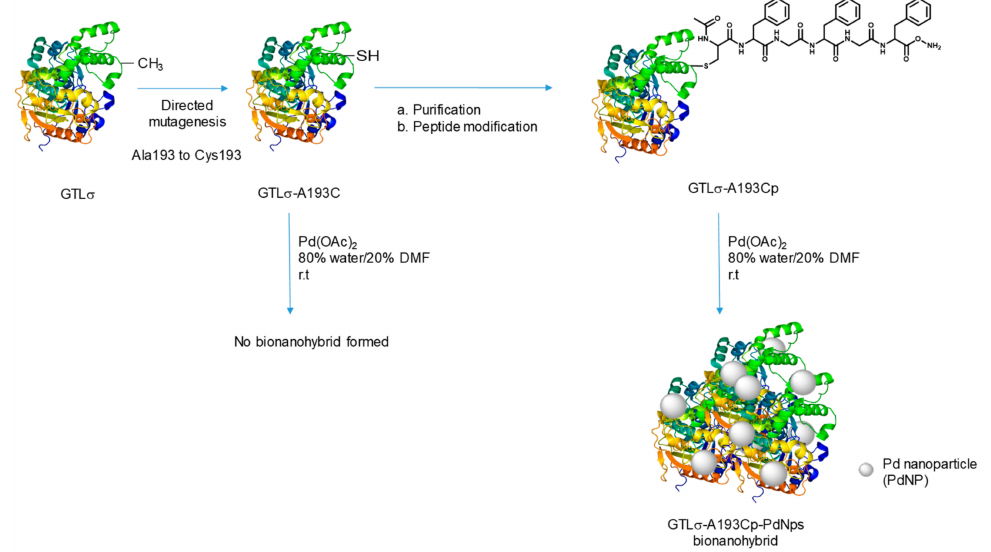
Figure 2. Preparation of the Geobacillus thermocatenulatus (GTL) σ -A193Cp- palladium (0) nanoparticles (PdNPs)